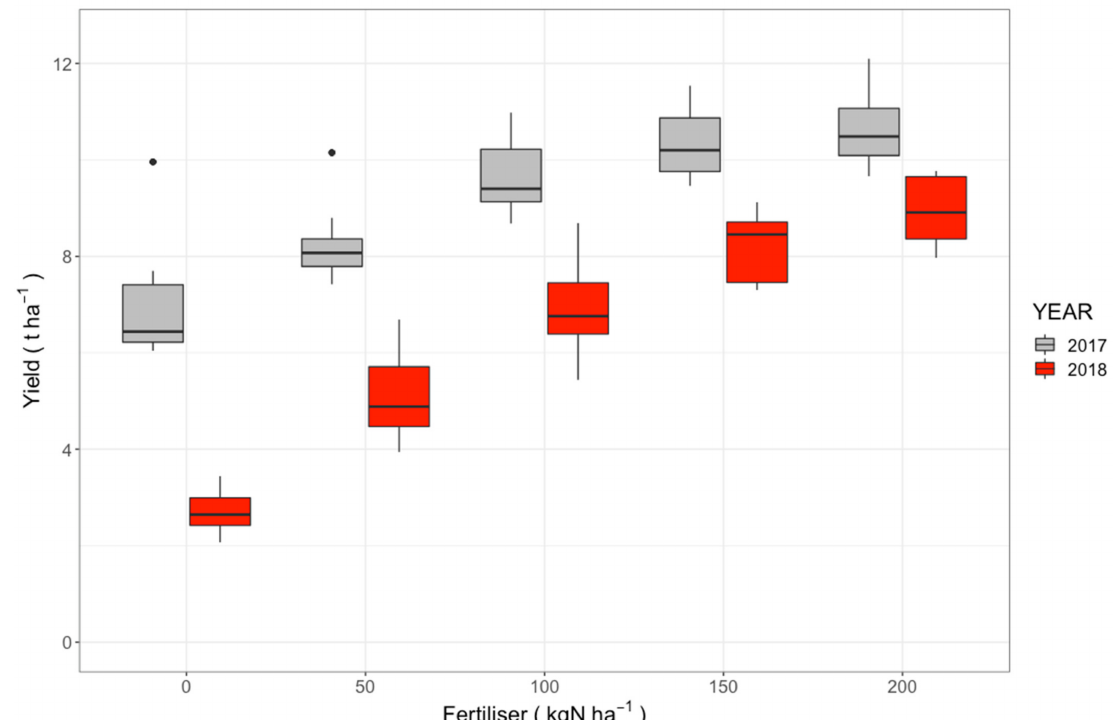
Figure 2. Variation in yield of winter wheat with fertilizer treatment and year of experiment (colors). The box plot shows the median, inter-quartile and 90% range. For each treatment and year, n = 10. Inter-annual differences are relatively and absolutely smaller at high fertilization